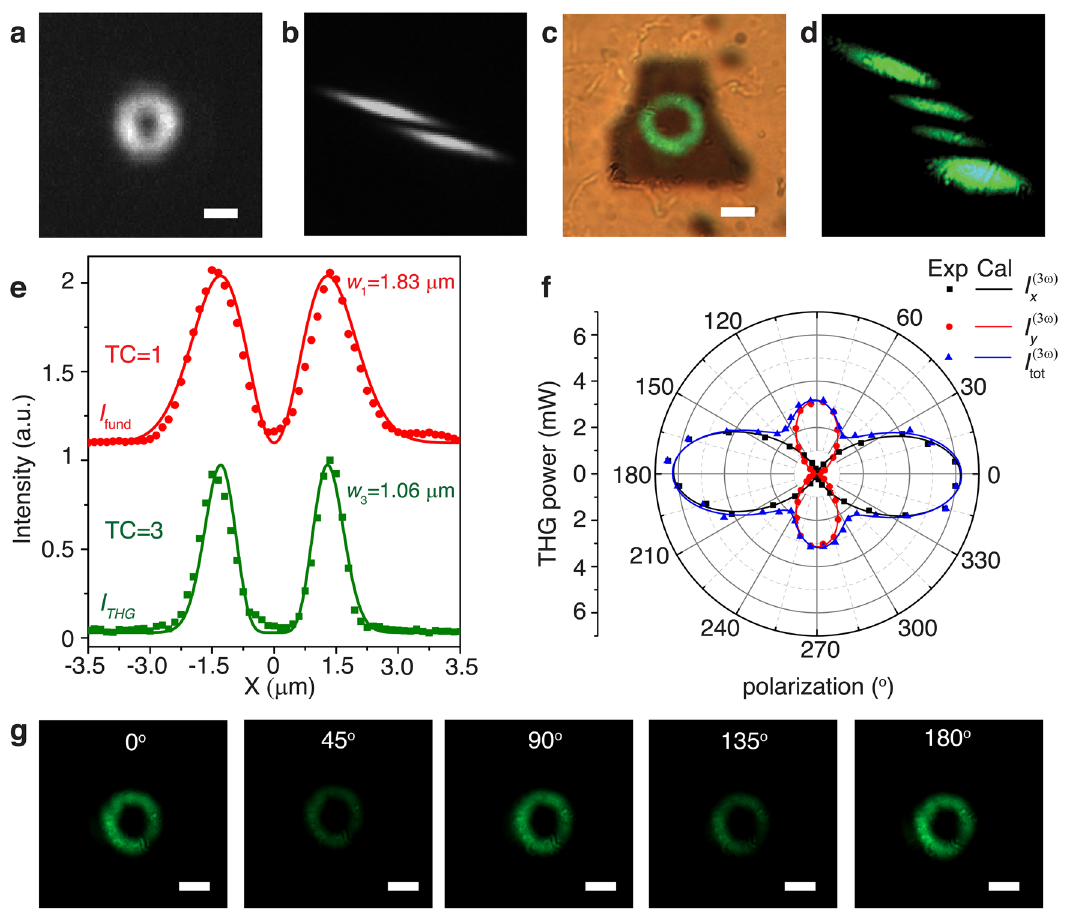
Fig. 7 TH vortex conversion from lengenbachite fl akes. a EMCCD image of the incident fundamental vortex beam with TC = 1 focused on the 44 nm-thick lengenbachite fl ake. b Cylindrical lens image of the fundamental vortex beam con fi rming TC to be 1. c CCD image of the converted TH vortex beam from the fl ake. d Cylindrical lens image of the TH vortex beam indicating TC to be 3. e Measured line pro fi les of the intensity of fundamental and TH vortex beams with TC of 1 and 3 (data points), which are fi tted by the calculated pro fi les of E 2 (solid curves). f Dependence of the TH vortex beam power on the linear polarization angle of the fundamental vortex beam. g THG images of the converted vortex beams from the fl ake for different incident linear polarizations at 0°, 45°, 90°, 135°, and 180°. Scale bars are 2